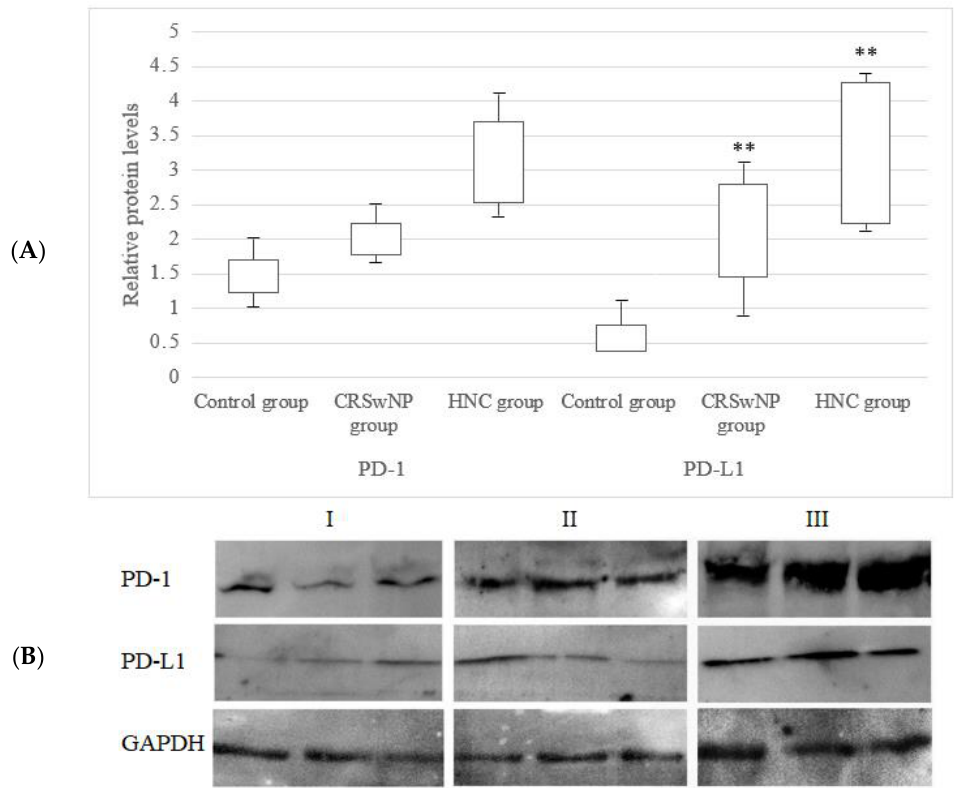
Figure 4. PD-1 and PD-L1 protein expressions in the tissue of the examined patients with CRSwNP and HNC ( A ). Representative Western blots of the PD-1 and PD-L1 protein expressions ( B ): control subjects ( I ); CRSwNP patients ( II ); HNC patients ( III ). ** p < 0.01 versus the control group.